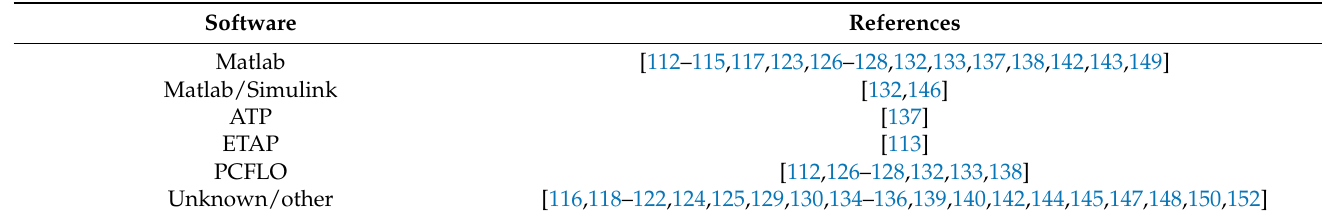
Table 4. Software tools.